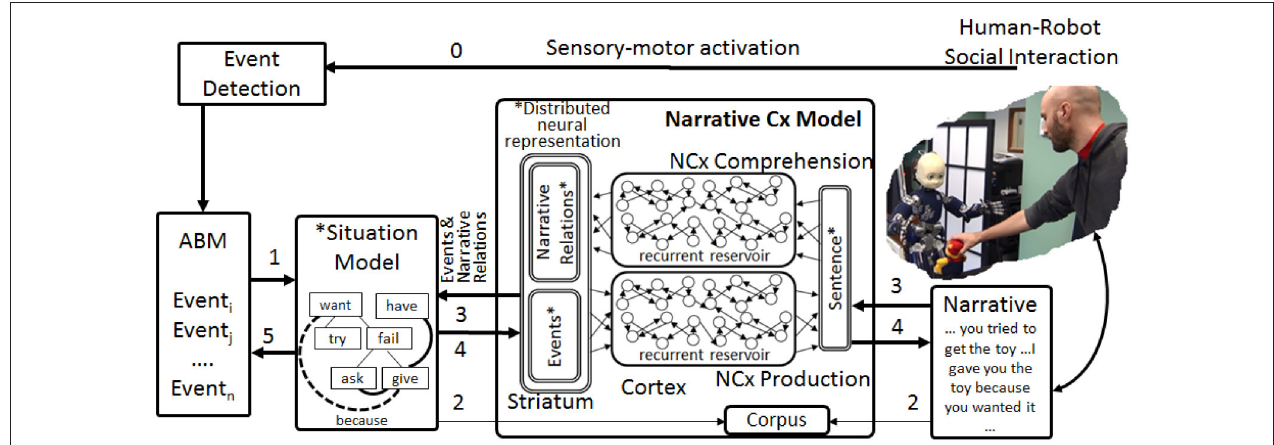
FIGURE 1 | Narrative processing system overview. Implemented Embedding of Narrative Construction (NCx) Model in the iCub cognitive system. Encoding experience in the ABM and situation model. The robot interacts with humans via our extended cooperative interaction infrastructure ( Lallée et al., 2012, 2013; Petit et al., 2013; Mealier et al., 2016 ) (not shown here). 0—Propositional representations extracted by perceptual processing for Event Detection and encoded in the Auto-Biographical Memory (ABM) ( Pointeau et al., 2014). 1—Events encoded in the ABM are directly converted into Initial State, Goal, Action, Result, Final state (IGARF) representations in the Situation Model. Thus, the robot’s experience is encoded the ABM, and provisionally in the situation model. Enrichment of experience by narrative: The human narrates the interaction. 2—Sentences in the narrative are aligned with meaning coded in the Situation Model in order to generate a corpus of sentence-meaning pairs that is used to train the comprehension and production models. 3.1 The narrative that describes the observed events is processed by the trained comprehension model, and the additional relational links coded in the narrative are used to enrich the Situation Model (e.g., dotted “because”). 3.2 Based on a new narrative that matches a learned narrative construction, the system can create a new situation model (inheriting narrative relations). 4. Once a situation model has been instantiated, the system extracts the meaning to the narrative production model to generate the corresponding narrative. 5. Once a situation model has been enhanced by narrative, its contents can be written into the ABM as an enriched experience—thus narrative enriches and modifies experience (not implemented). New experiences that overlap with learned situation models will inherit the enriched narrative structure (*indicates reservoir-compatible distributed neural